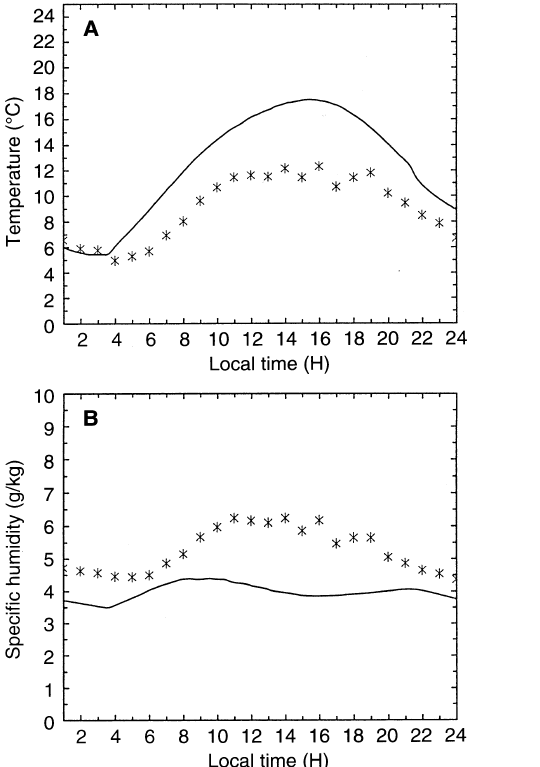
Fig. 13A,B. Time evolution of the measured and computed values of A the 2 m temperature and B the 2 m specific humidity on July 12 from 0000 LST to 2400 LST. The stars correspond to observations at site 7